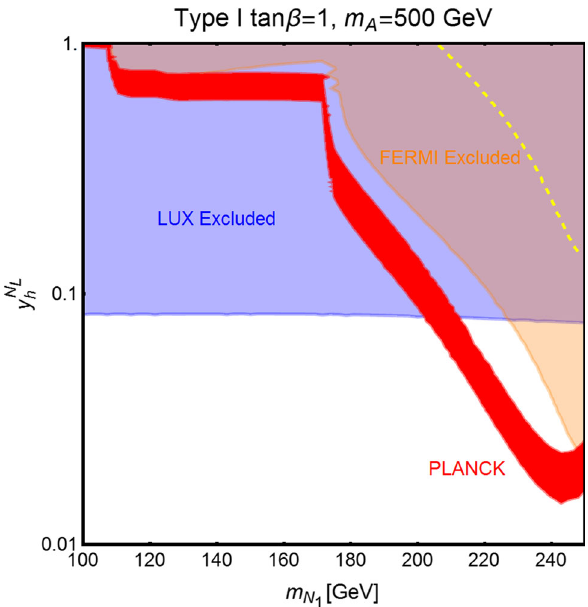
Fig. 9 Comparison between the different DM constraints from one of the benchmarks considered in Fig. 8. In addition to the already consid- ered constraints from relic density and DD the figure reports (in orange ) the excluded region by searches of gamma-rays in DSph [81] as well as the limit ( yellow dashed line ) from gamma-ray lines